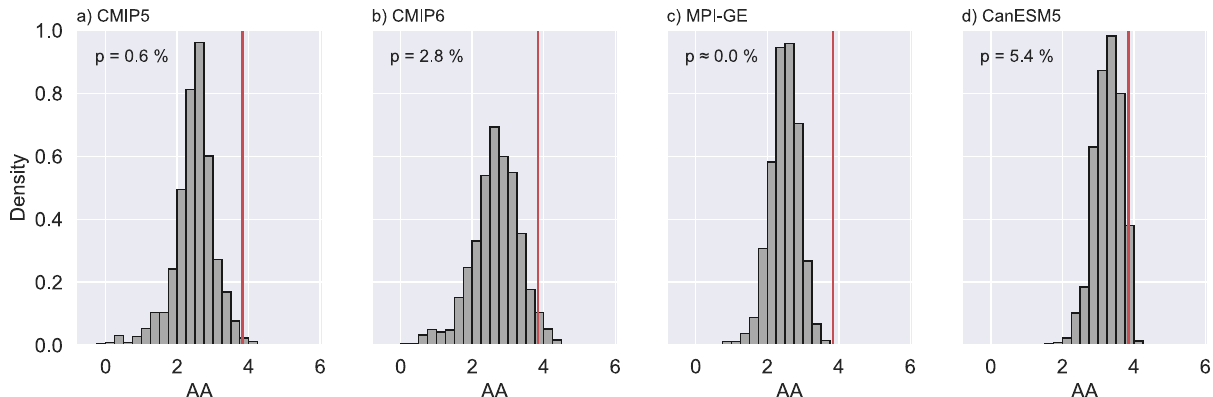
Fig. 6 The probability of observed Arctic ampli fi cation in the climate model ensembles. Frequency distributions of all possible 43-year AA ratios between 1970 and 2040 in ( a ) CMIP5, ( b ) CMIP6, ( c ) MPI-GE, and ( d ) CanESM5 ensemble. The red line denotes the observed 43-year AA ratio, as calculated for 1979 –